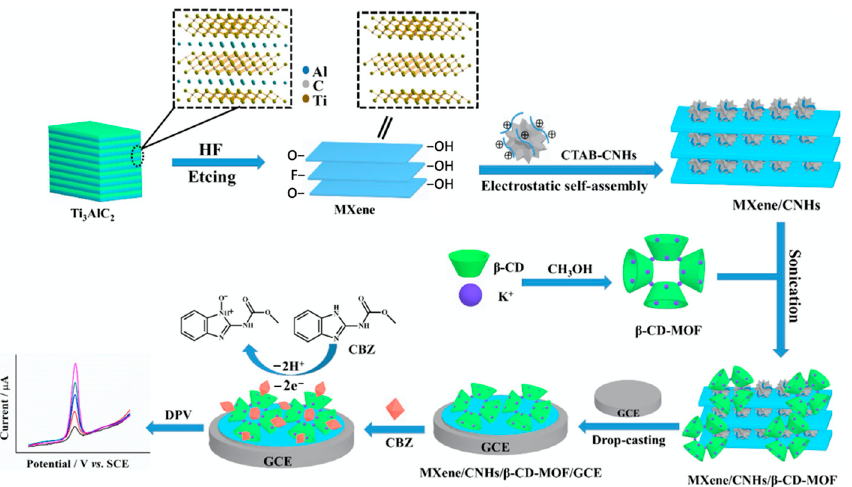
Figure 7. Synthetic route of the MXene/CNHs/ β -CD-MOFs and the sensing strategy for carbendazim. Bulk Ti 3 AlC 2 is etched and exfoliated, then combined with carbon nanohorns (CNHs), decorated with β -CD-MOF and drop casted onto a glassy carbon electrode (GCE). Reproduced with permission from Tu et al. [154], J. Hazard. Mater.; published by Elsevier, 2020.